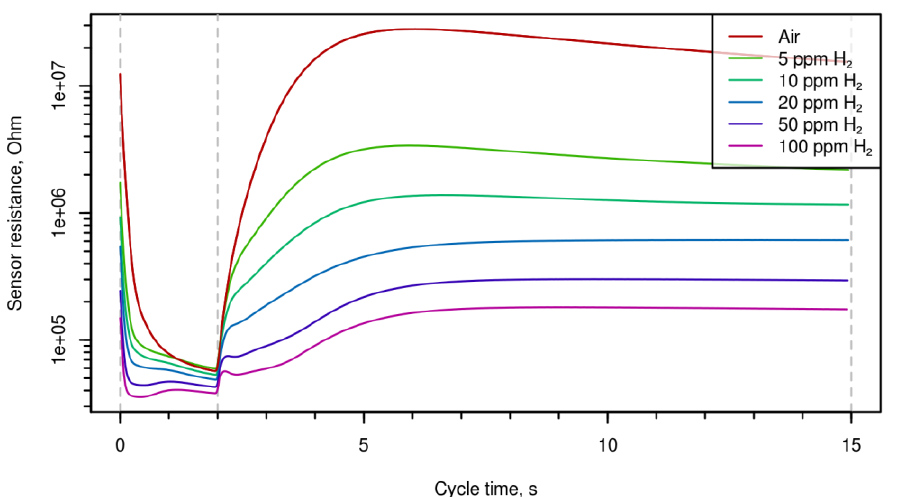
Figure 1. Time-resistance dependence for different hydrogen concentrations during one measurement period.